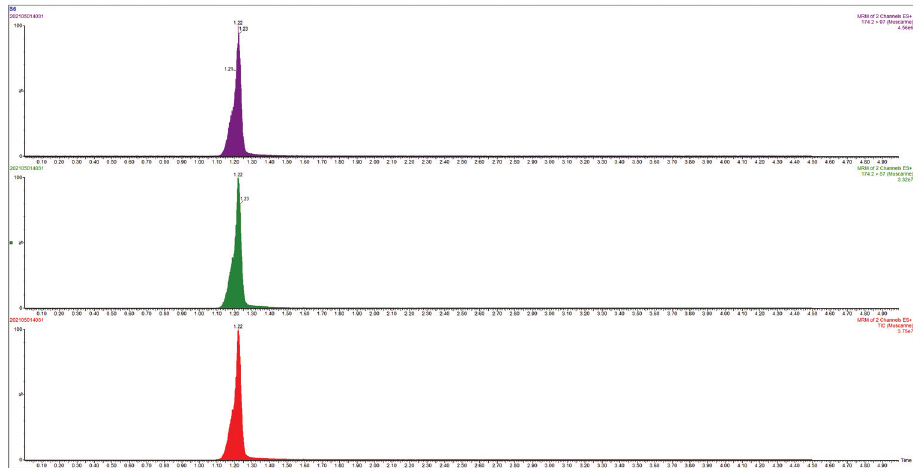
Figure 8. Representative chromatograms of